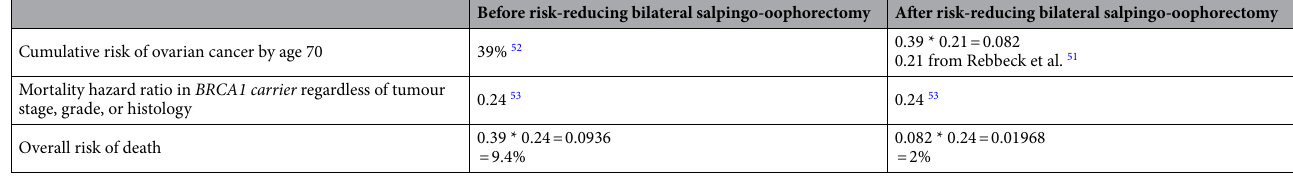
Table 3. Calculating risk of death from ovarian cancer in P/LP BRCA1 variant carriers. 9.4% / 2% = 4.7-fold reduction in risk of death from ovarian cancer in P/LP BRCA1 carrier.